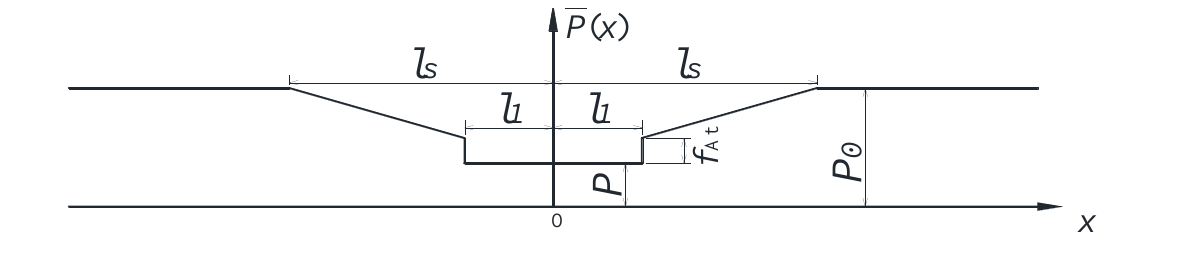
Figure 2. Axial compressive force distribution.